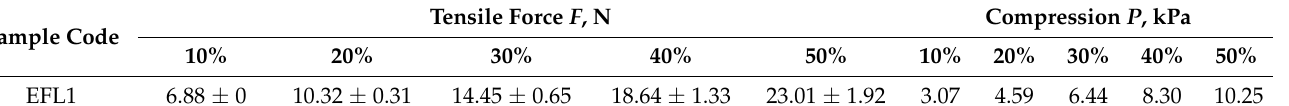
Table 3. Tensile force and corresponding compression at the different stretch